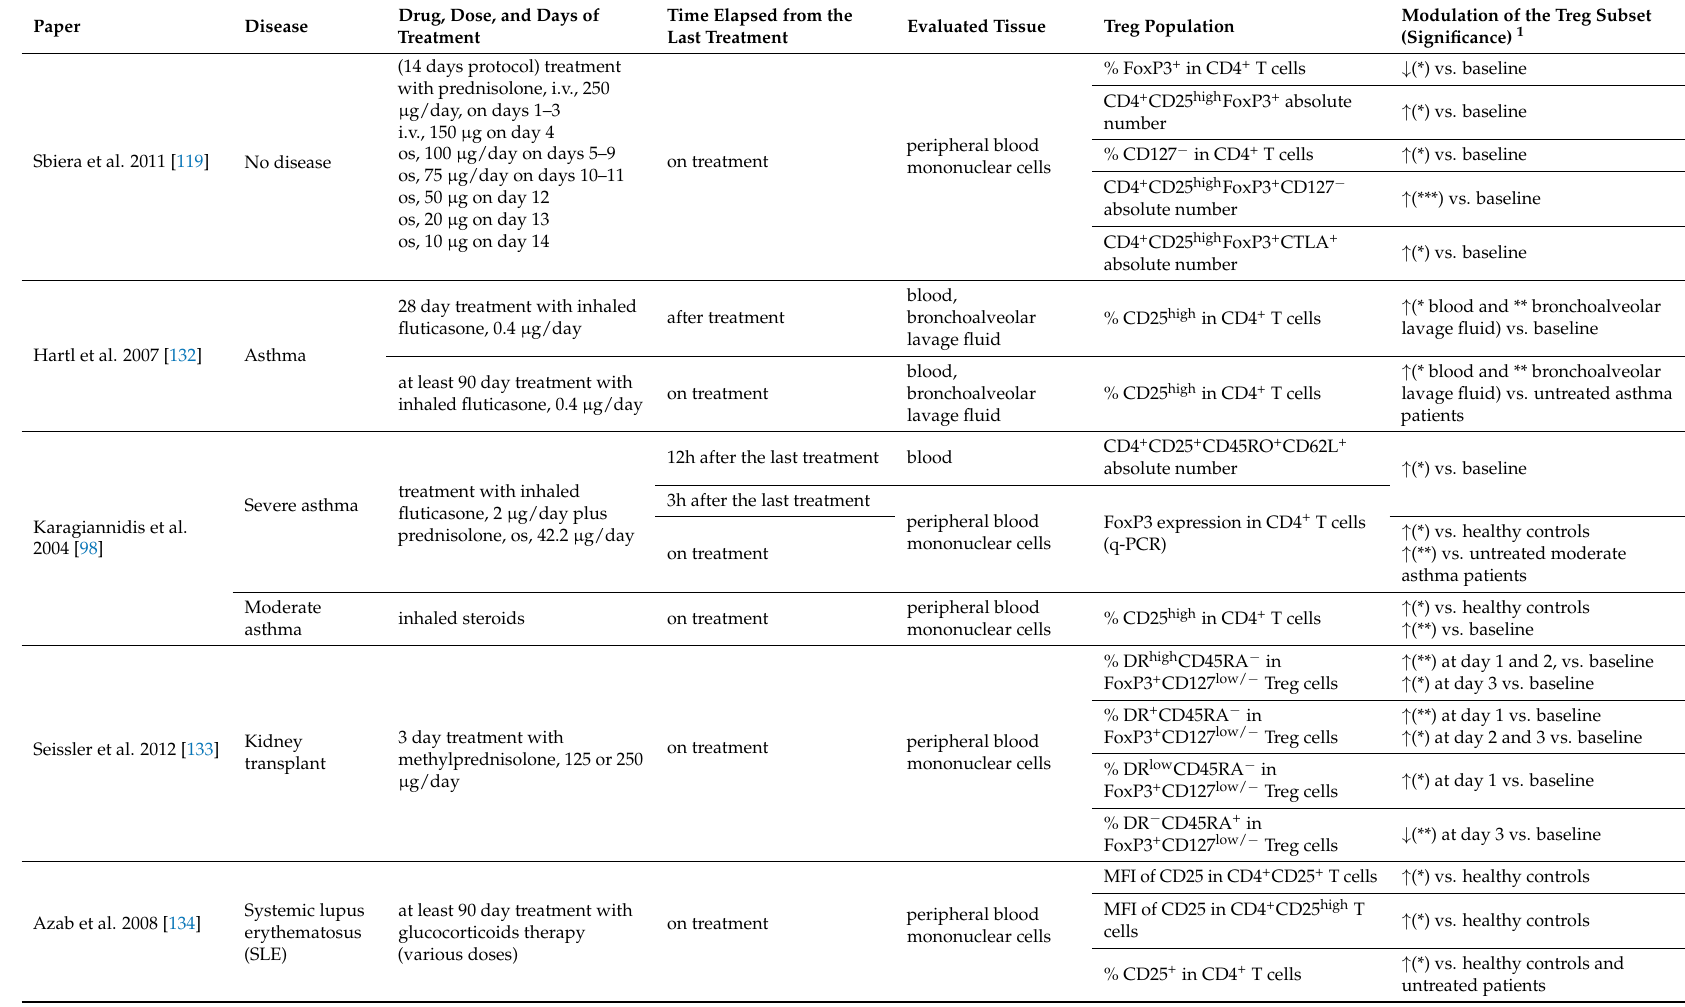
Table 2. Modulation of human Treg cell subsets following GC treatment in health and